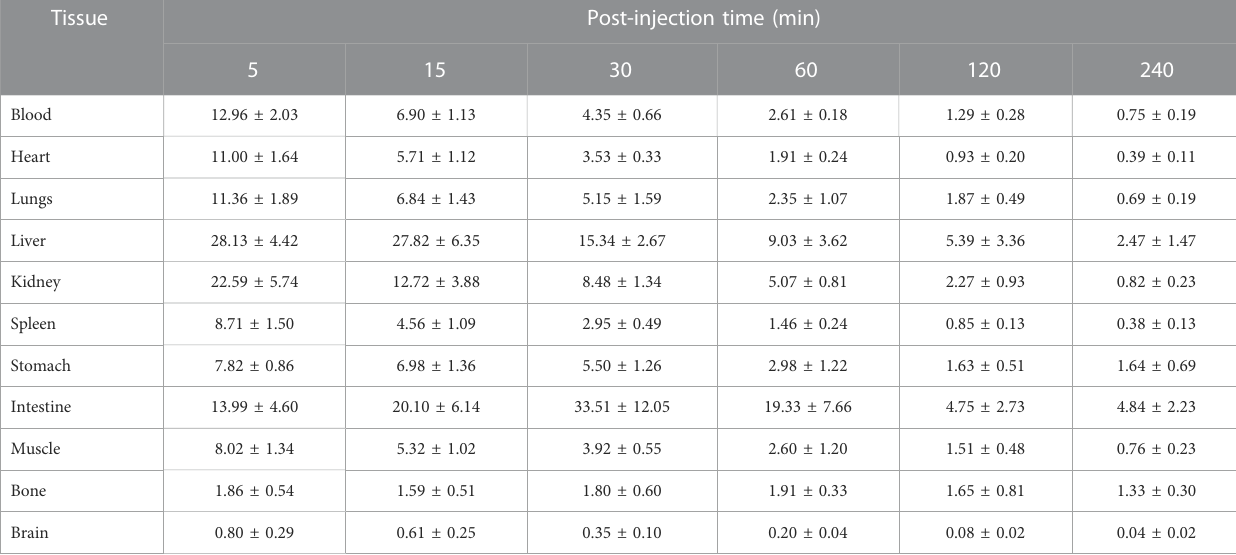
TABLE 1 Biodistribution data on [ 18 F]3 in normal Kunming